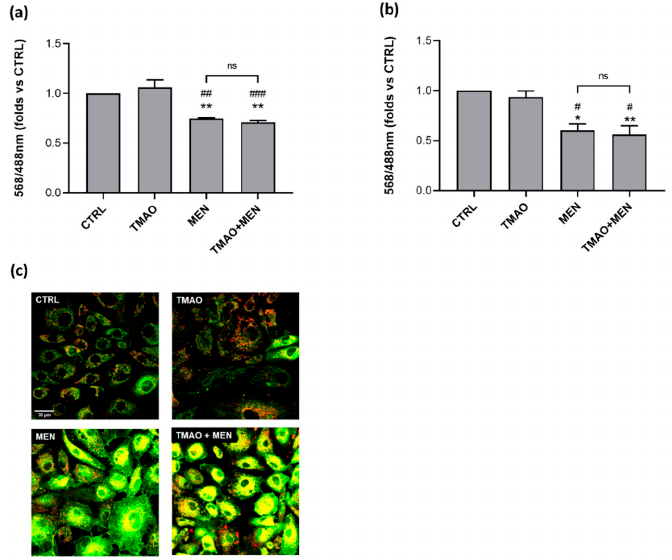
Figure 2. TMAO does not impact mitochondrial membrane potential. Bar graphs of 568/488 nm ratio related to control condition (CTRL) showing that TMAO was not able to induce mitochondrial mem- brane depolarization after ( a ) 1 h and ( b ) 24 h of treatment and it acted as a neutral factor in presence of a stressor, as MEN, that on the contrary induced a reduction of 568/488 nm ratio. Number of cells for each condition in 1 h treatment: CTRL: 180; TMAO: 180; MEN: 180; TMAO + MEN: 180 (n = 3 independent experiments). Number of cells for each condition in 24 h treatment: CTRL: 83; TMAO: 83; MEN: 83; TMAO+MEN: 83 (n = 3 independent experiments). * p < 0.05, ** p < 0.01 (vs. CTRL); # p < 0.05, ## p < 0.01, ### p < 0.001 (vs. TMAO). ( c ) Representative confocal microscopy images of BAE- Merged images at 568 nm and 488 nm (magnification